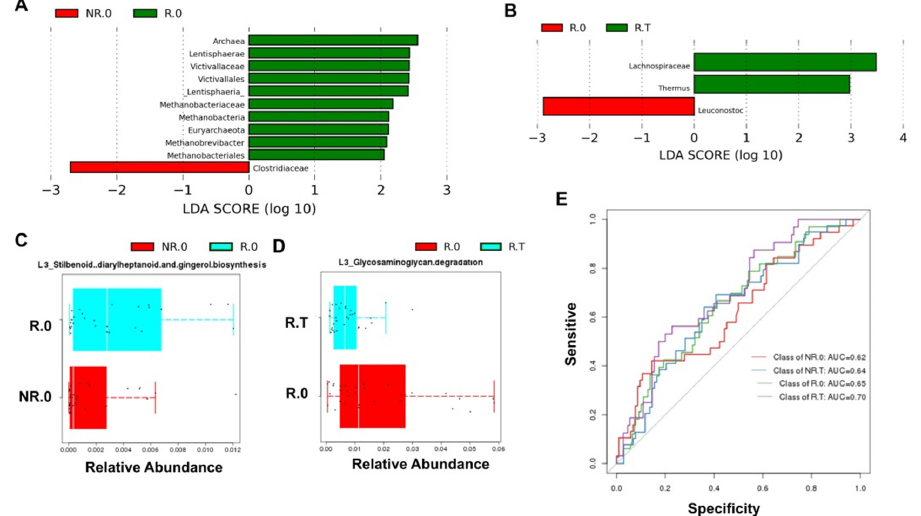
Figure 3. LEfSe analysis results and Picrust prediction in each group. ( A ) LEfSe analysis with significantly different representations in the R.0 group and NR.0 group. ( B ) LEfSe analysis with significantly different representations in the R.0 group and R.T group. ( C ) Picrust prediction of functional differences in the R.0 group and NR.0 group. ( D ) Picrust prediction of functional differences in the R.0 group and R.T group. ( E ) The AUC based on the microbiome for the R.0 group, R.T group, NR.0 group and NR.T group.